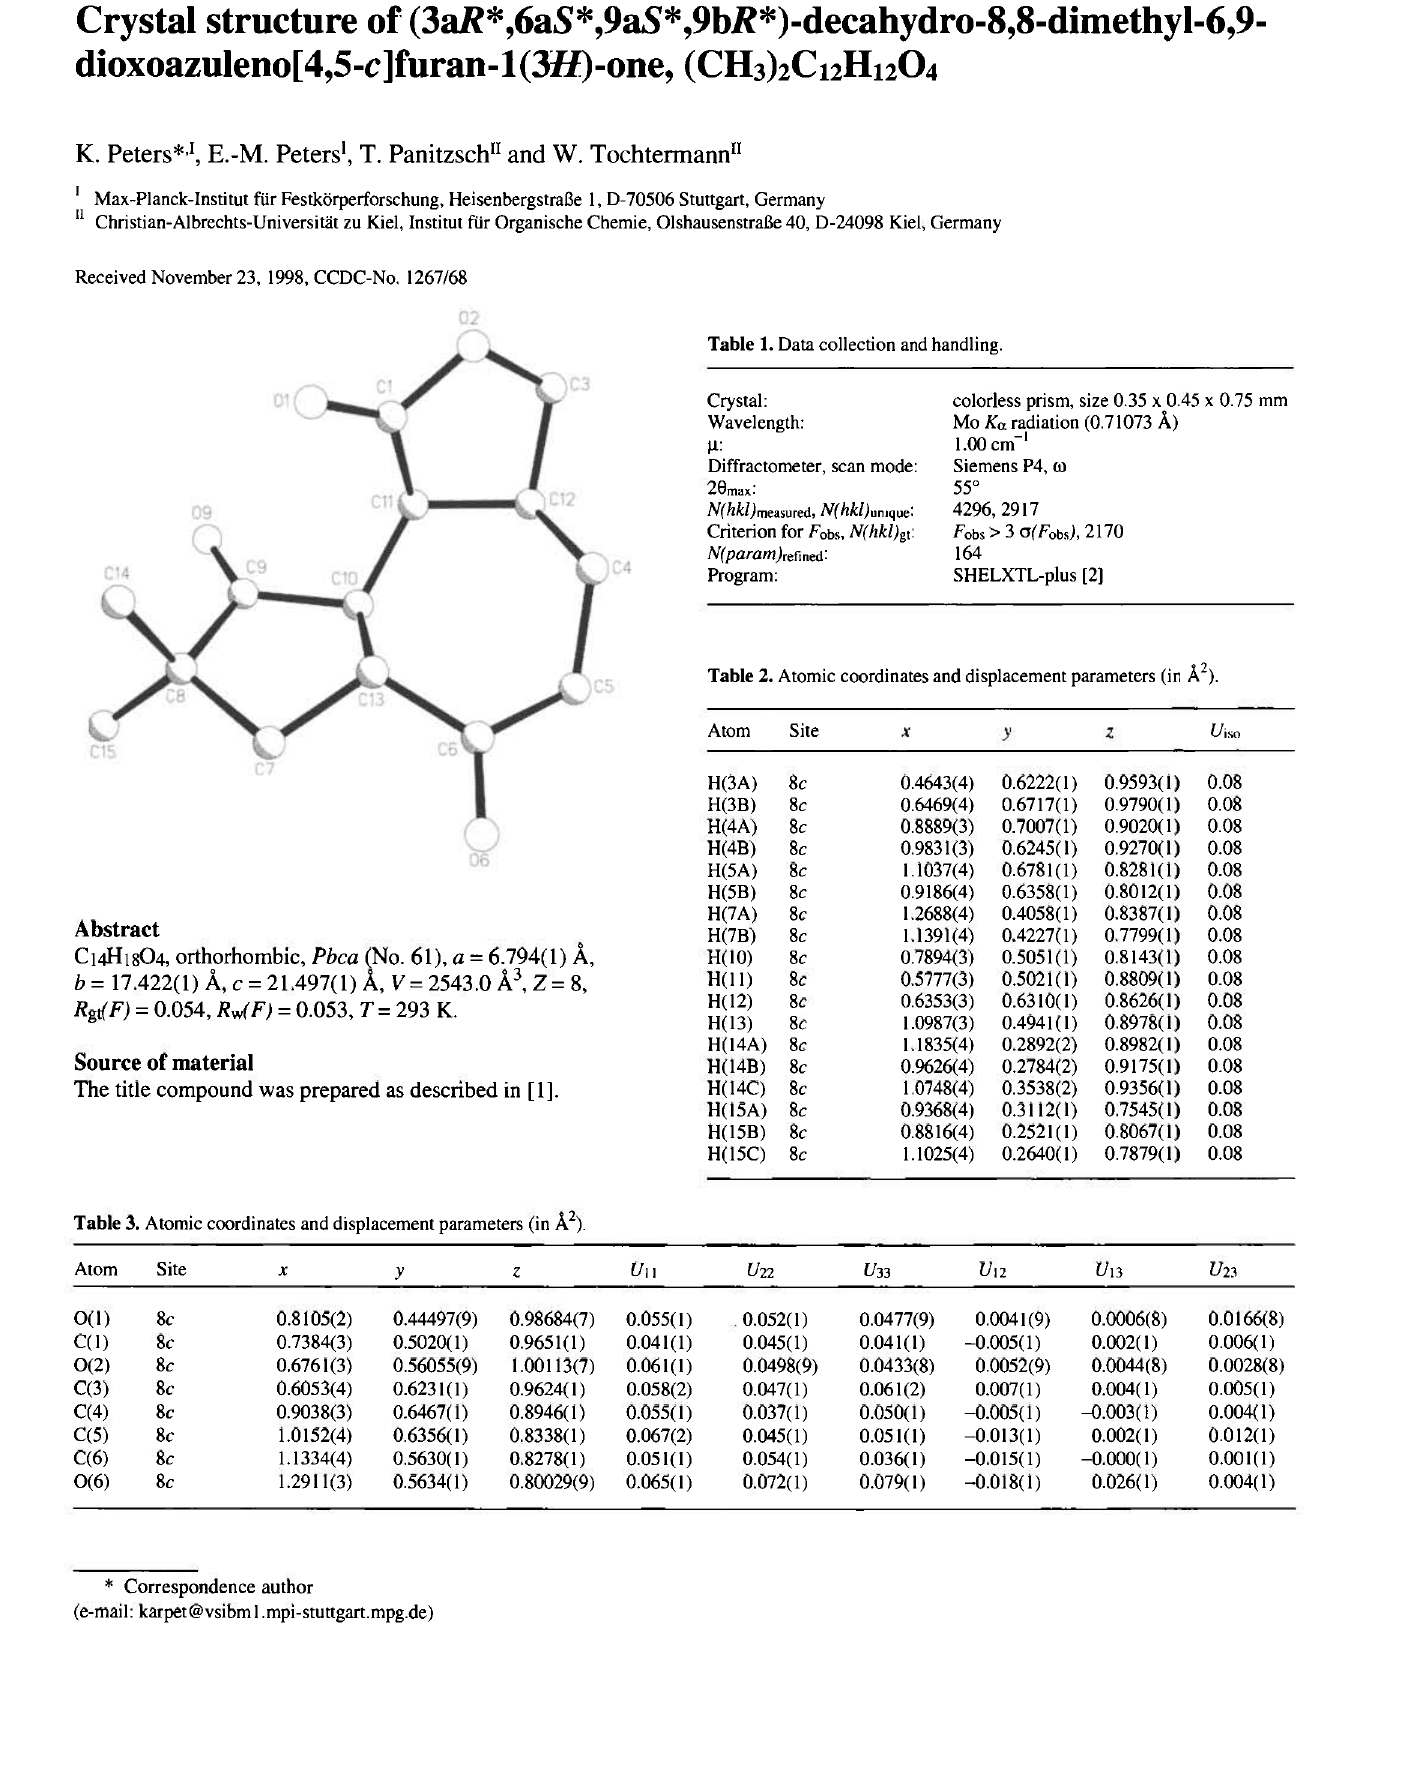
Table 3. Atomic coordinates and displacement parameters (in Ä 2